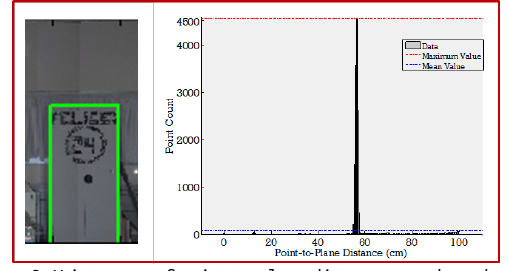
Figure 8. Histogram of point-to-plane distances: cupboard case. Three peak values are detected in the histogram of figure 9 at 2 cm., 32 cm. and 34 cm. from the plane resulting in the classification of a non-door object. This object corresponds to a bookshelf that has a total depth of 33.5 cm. whereas the shelves have a depth of 32 cm. The peak value at 2cm corresponds to the inner surface of the bookshelf.